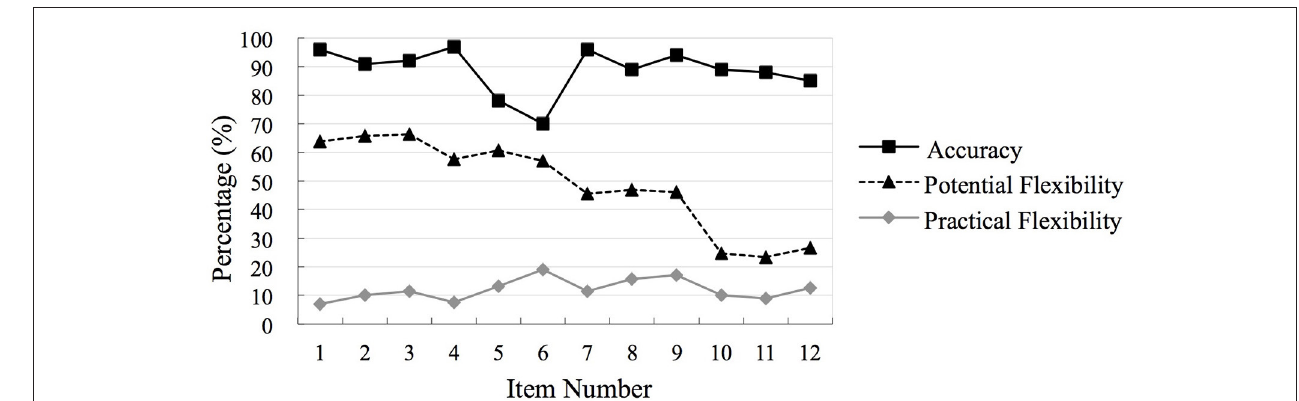
FIGURE 1 | Distribution scoring percentage of accuracy. Practical flexibility and practical flexibility on each item ( N = 158).